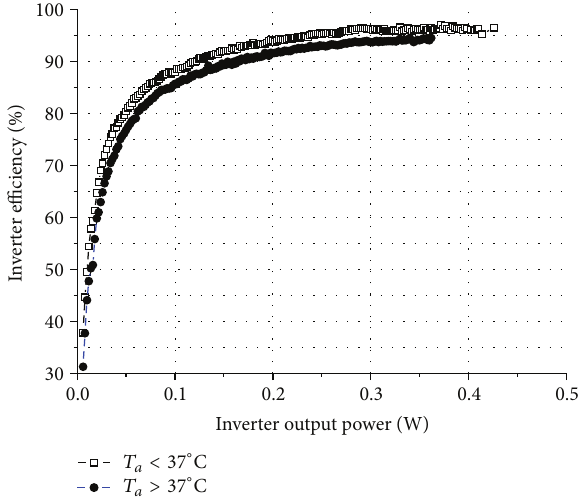
Figure 5: Average inverter efficiency of two different operating conditions: 𝑇 𝑎 < 37 ∘ C and 𝑇 𝑎 > 37 ∘